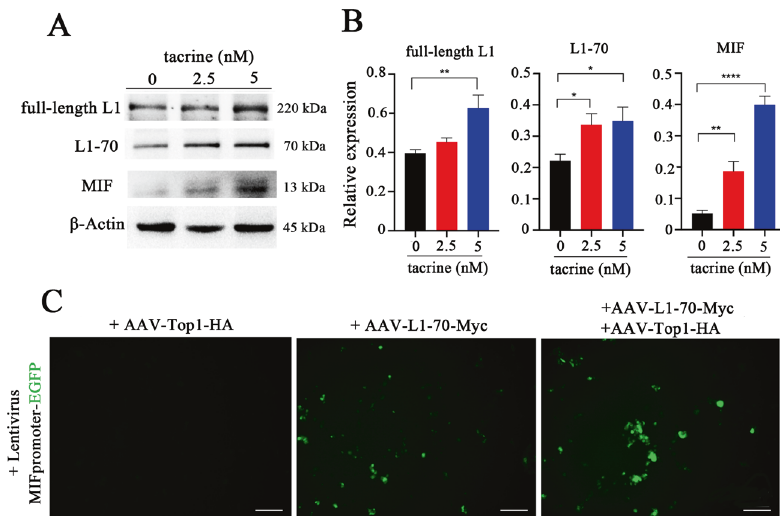
Fig. 4 The L1-70/Top1 complex regulates MIF expression in hippocampal neurons. A Western blot analysis of the cell lysates of mouse neuroblastoma N2a cells treated with tacrine. Antibodies against L1 cytoplasmic domain, against MIF and against β -actin were used for immunoblotting. Expression of L1 and L1-70 was induced by tacrine and accompanied by an increase in MIF expression level. B Relative full- length L1, L1-70, and MIF levels were calculated and normalized to β -actin. The data represent means ± SD, * p < 0.05, ** p < 0.01, **** p < 0.0001, one-way ANOVA with Tukey ’ s post hoc test, three independent experiments. C U87 cells were transduced with lentivirus, encoding a MIF promoter-driven EGFP, for 48 h. Then, AAV-L1-70-Myc , AAV-Top1-HA , and both AAV-L1-70-Myc and AAV-Top1-HA were added. After 36 h, a strong EGFP signal could be found in cells transduced with both AAV-L1-70-Myc and AAV-Top1-HA